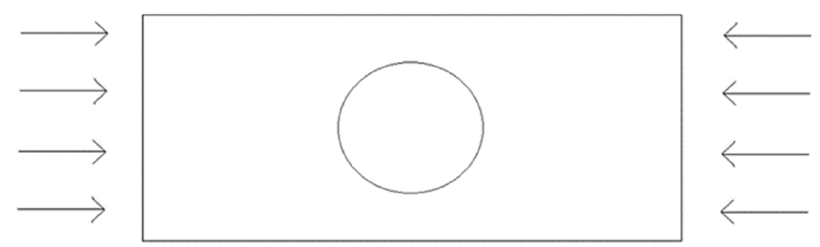
Figure 14. Original crack shape and compressive load for [( ± 45C) 2 ,(0C,0G) 4 ,( ± 45C) 2 ] specimen.